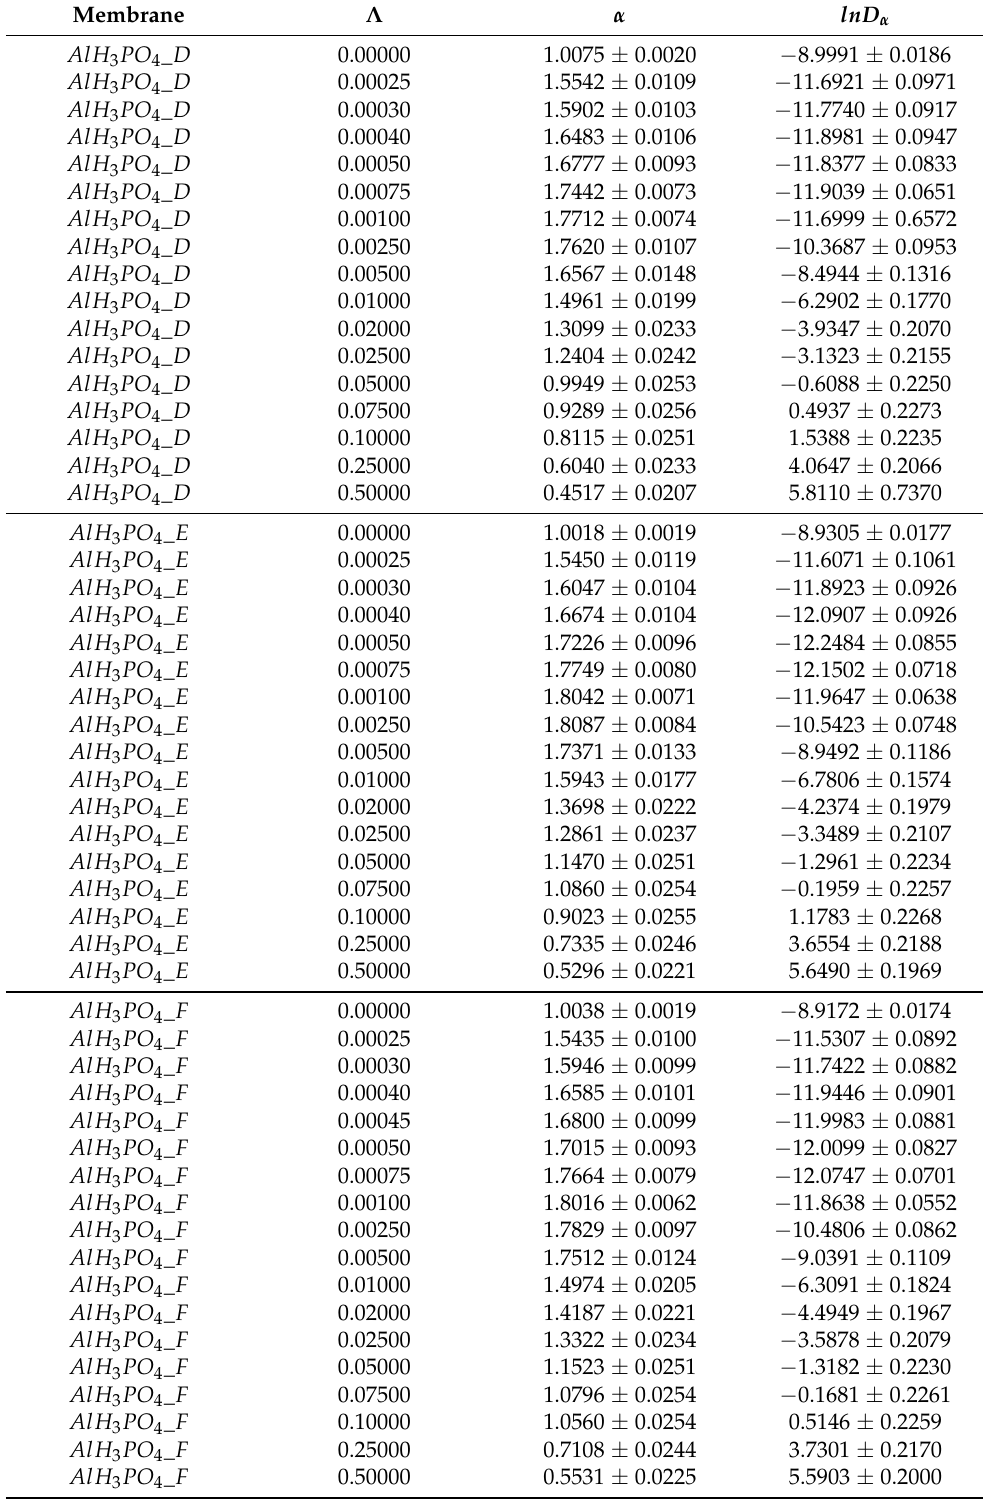
Table A2. Transport properties of alginate membrane cross-linked by phosphoric acid, containing 15 wt% of magnetite